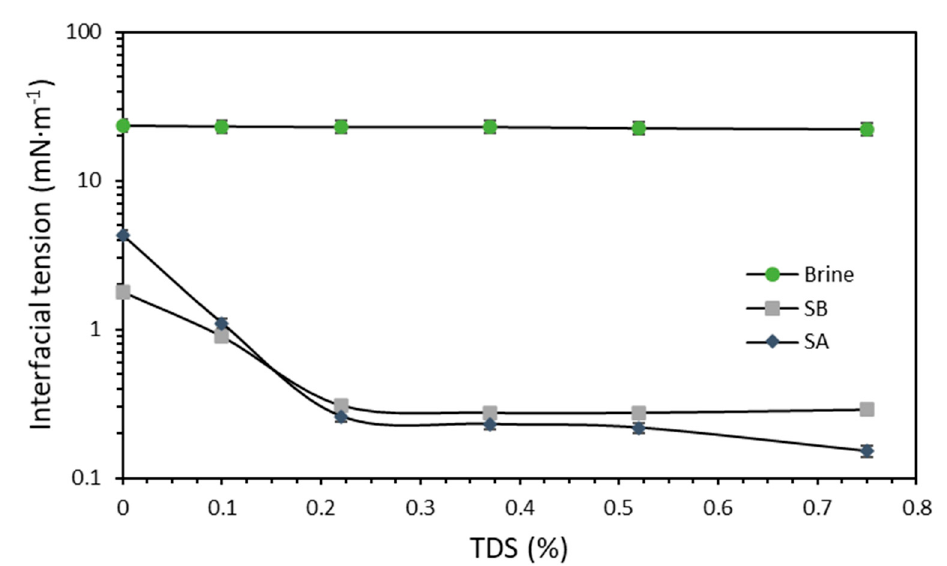
Figure 7. Interfacial tension measurements in brine total dissolved solid (TDS). The tests were conducted at 50 °C at a fixed concentration of 1000 mg·L − 1 for each surfactant (SA and SB). The symbols represent the experimental data, and the error bars correspond to their standard deviation.